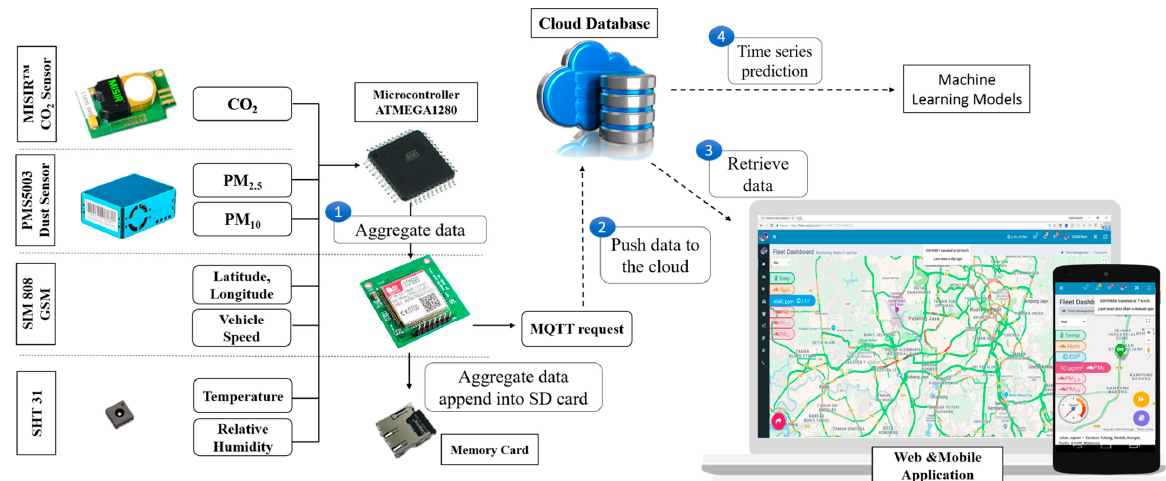
Figure 1. System architecture design for the in-vehicle air quality monitoring system.